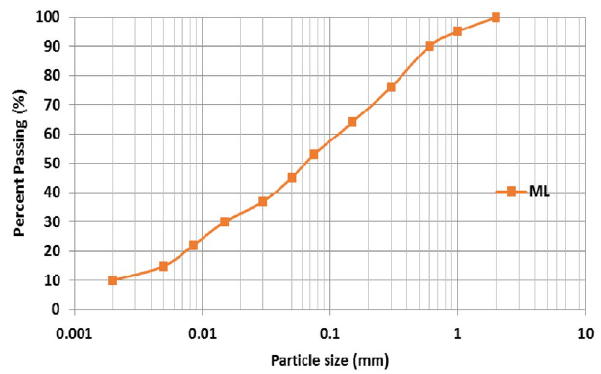
Fig. 3 Gradation curve of the studied soil